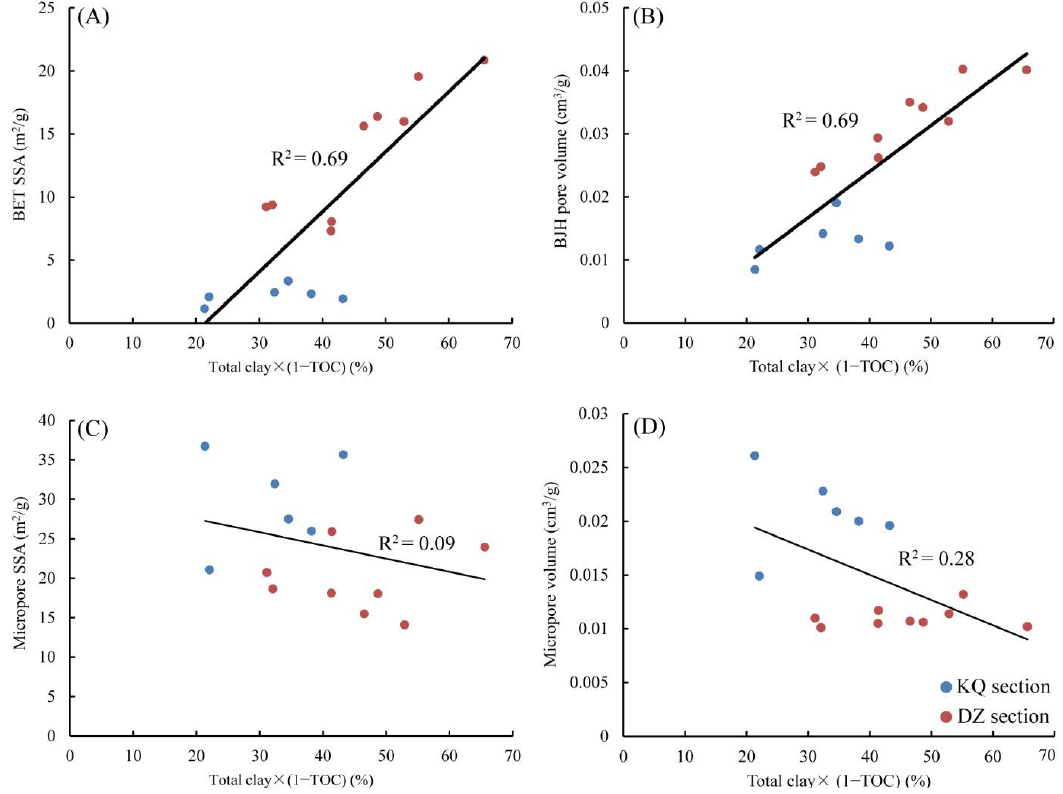
Figure 6. Relationships between ( A ) BET SSA; ( B ) BJH pore volume; ( C ) D-R micropore surface area; and ( D ) D-A micropore volume and total clay mineral content. The total clay mineral content was normalized by making the sum of organic matter and minerals in shales 100%.